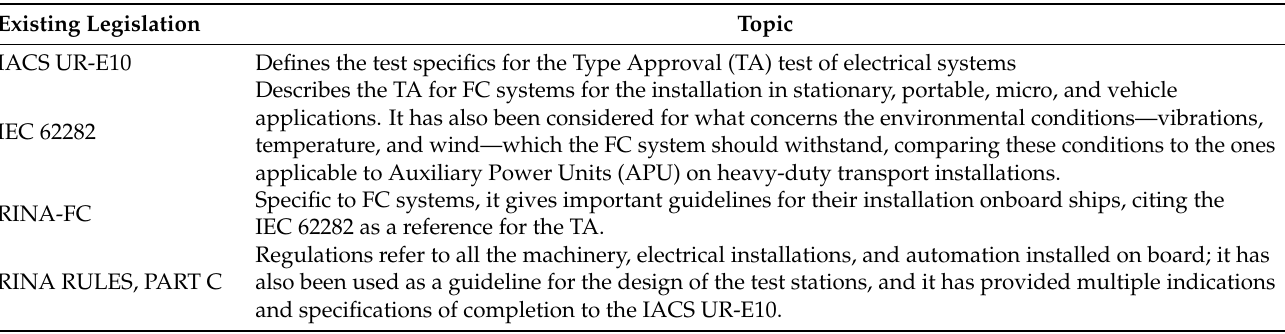
Table 4. Baseline legislatives considered in the FC-PROMATE project to draw new specific legislation for the installation of PEMFC systems onboard